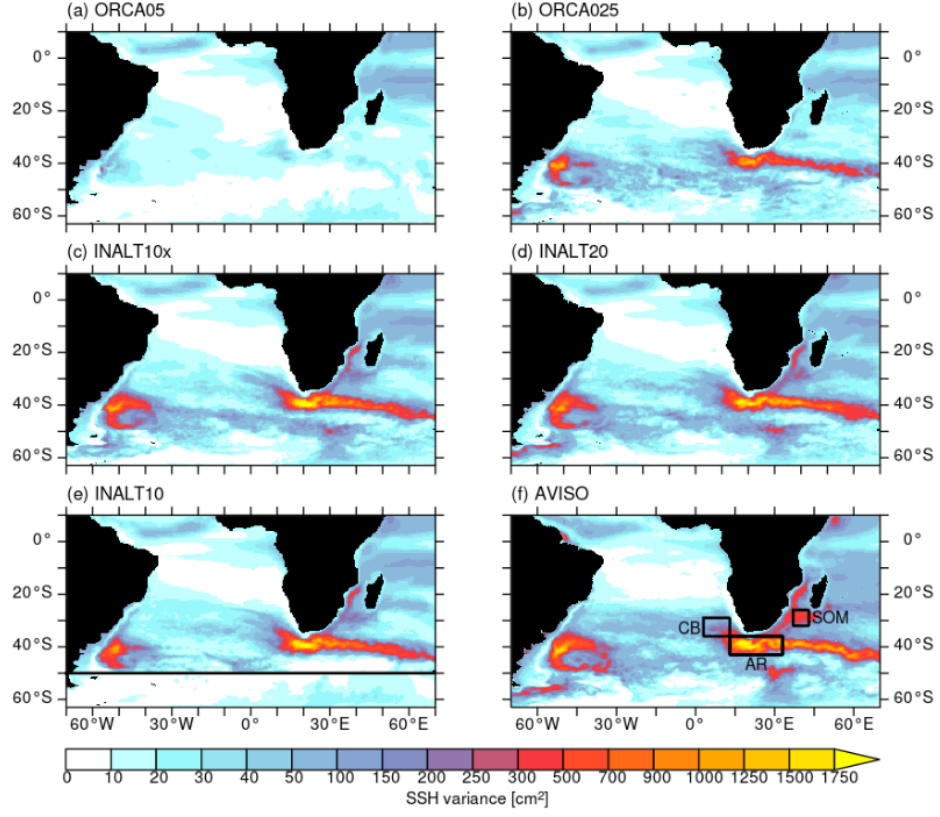
Figure 3. SSH variance (in cm 2 ) for the period 2000–2009 based on 5d averages from (f) satellite altimetry data (AVISO) compared to the hindcast experiments in the different configurations: (a) ORCA05, (b) ORCA025 (based on monthly averages), (c) INALT10x, (d) INALT20 and (e) INALT10. The horizontal line in panel (e) at 50 ◦ S indicates the southern boundary of the nested region in INALT10; the boxes in panel (f) mark the areas used for time series analyses (see Fig. 5). Note: the discrepancy in the temporal resolution for ORCA025 does not alter the findings (not